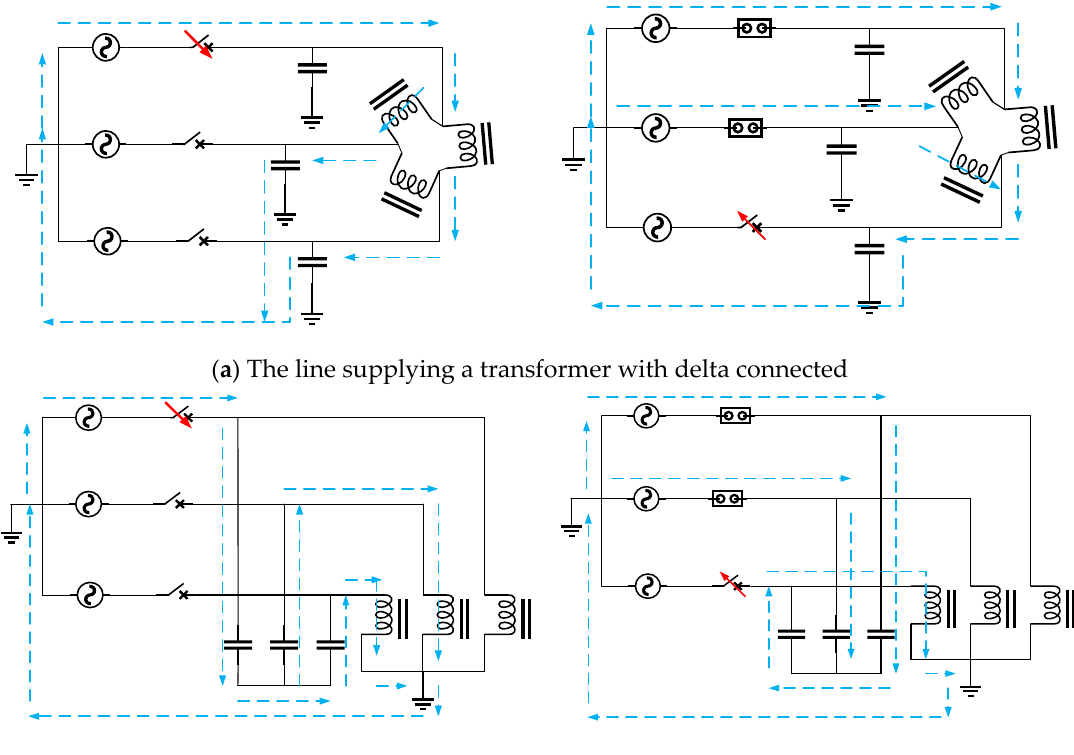
Figure 6. The transformer connection scheme.